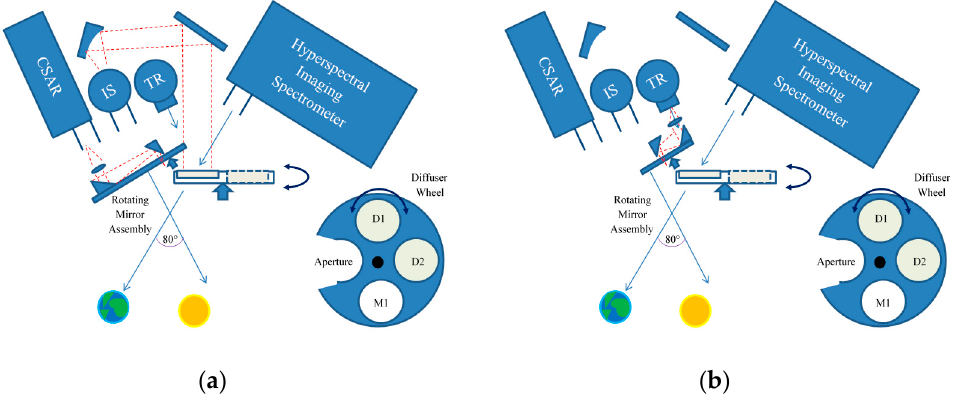
Figure 10. Schematic of step 1. The LDs illuminate (underfill) first ( a ) the CSAR cavity and then ( b ) the transfer radiometer (TR), by rotating the mirror